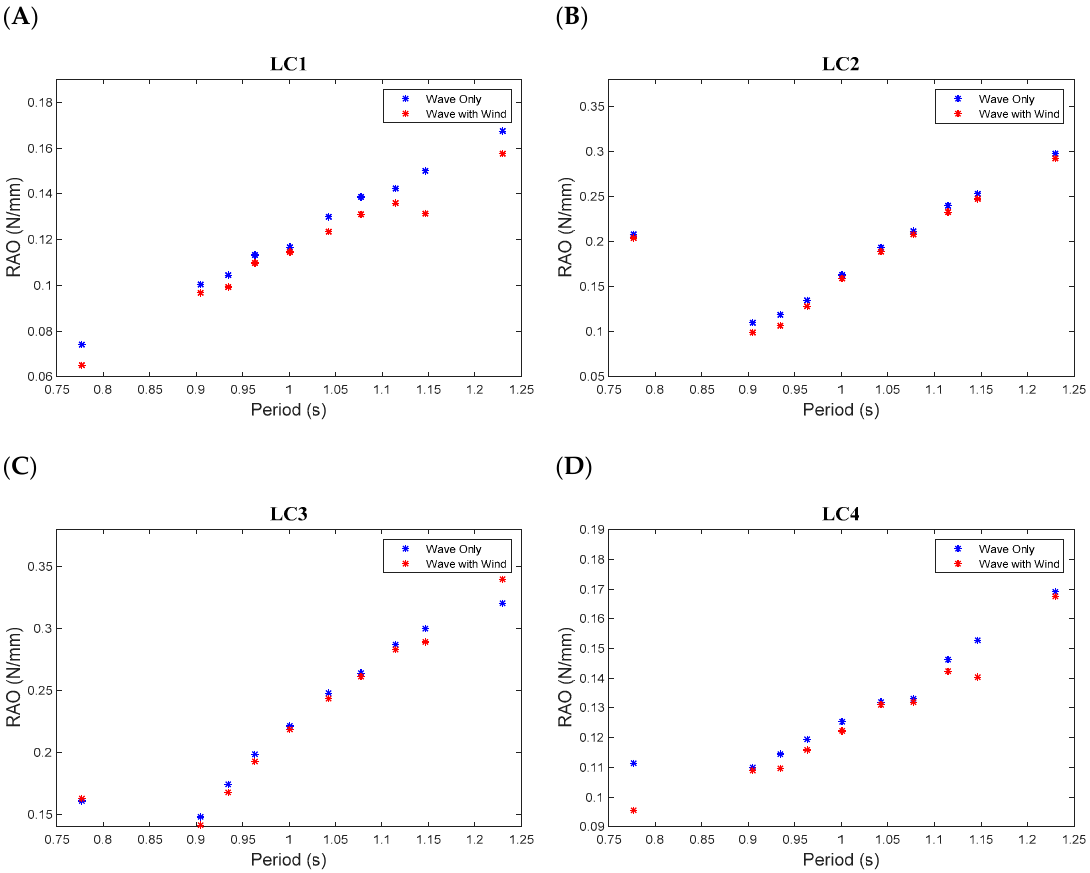
Figure 14. Dynamic tendon tension response amplitude operators for each tendon: LC1 RAO ( A ), LC2 RAO ( B ), LC3 RAO ( C ), LC4 RAO ( D ). Table 10. Maximum RAO values of the TLPWT model at T = 1.23 s.